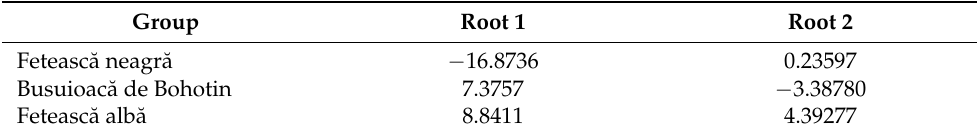
Table 10. Means of canonical variables.